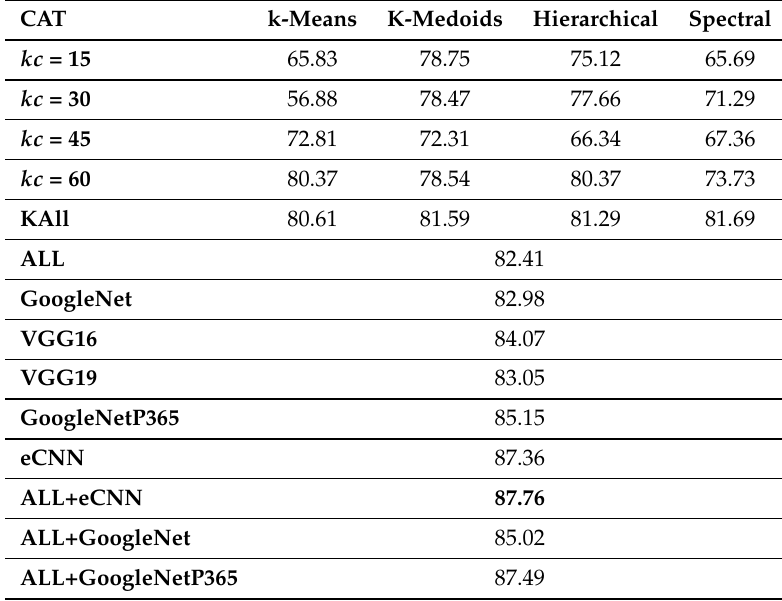
Table 3. Classification accuracy on the CAT